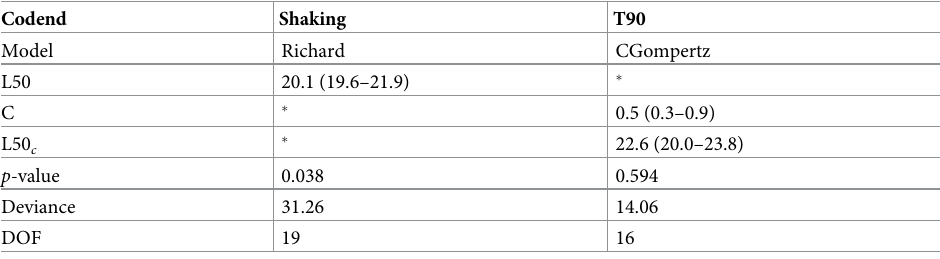
Table 6. Results from the best fit size selectivity